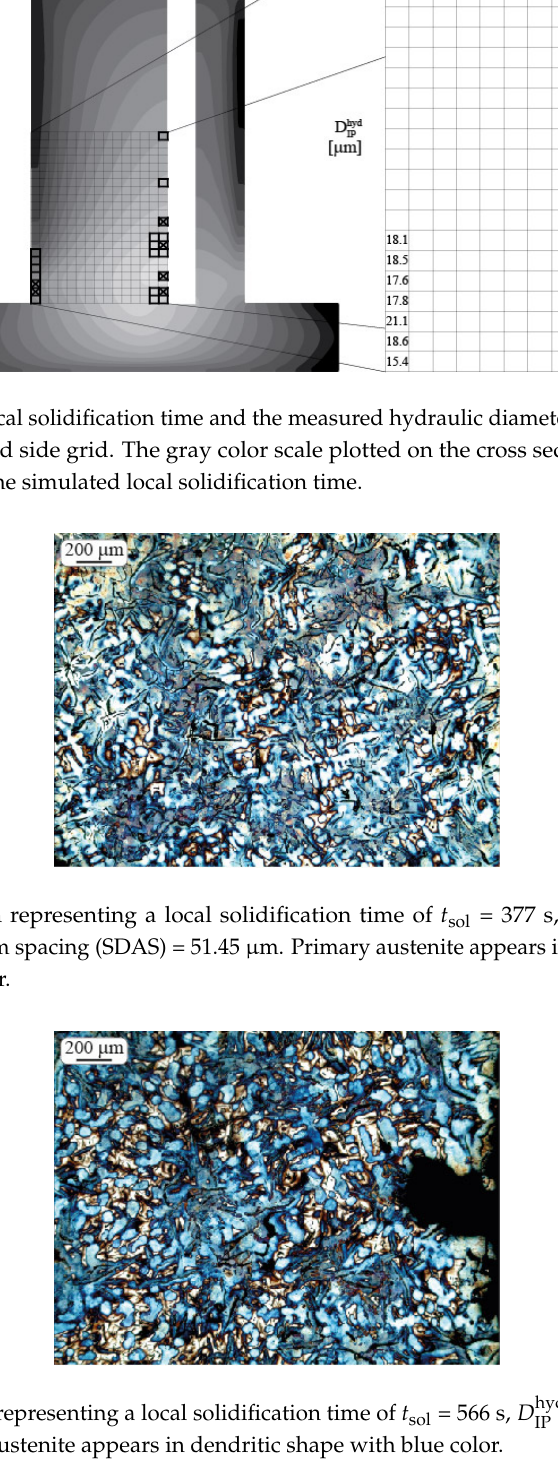
Figure 6. Micrograph representing a local solidification time of t sol = 566 s, D hyd = 76.79 μ m. Primary austenite appears in dendritic shape with blue color.